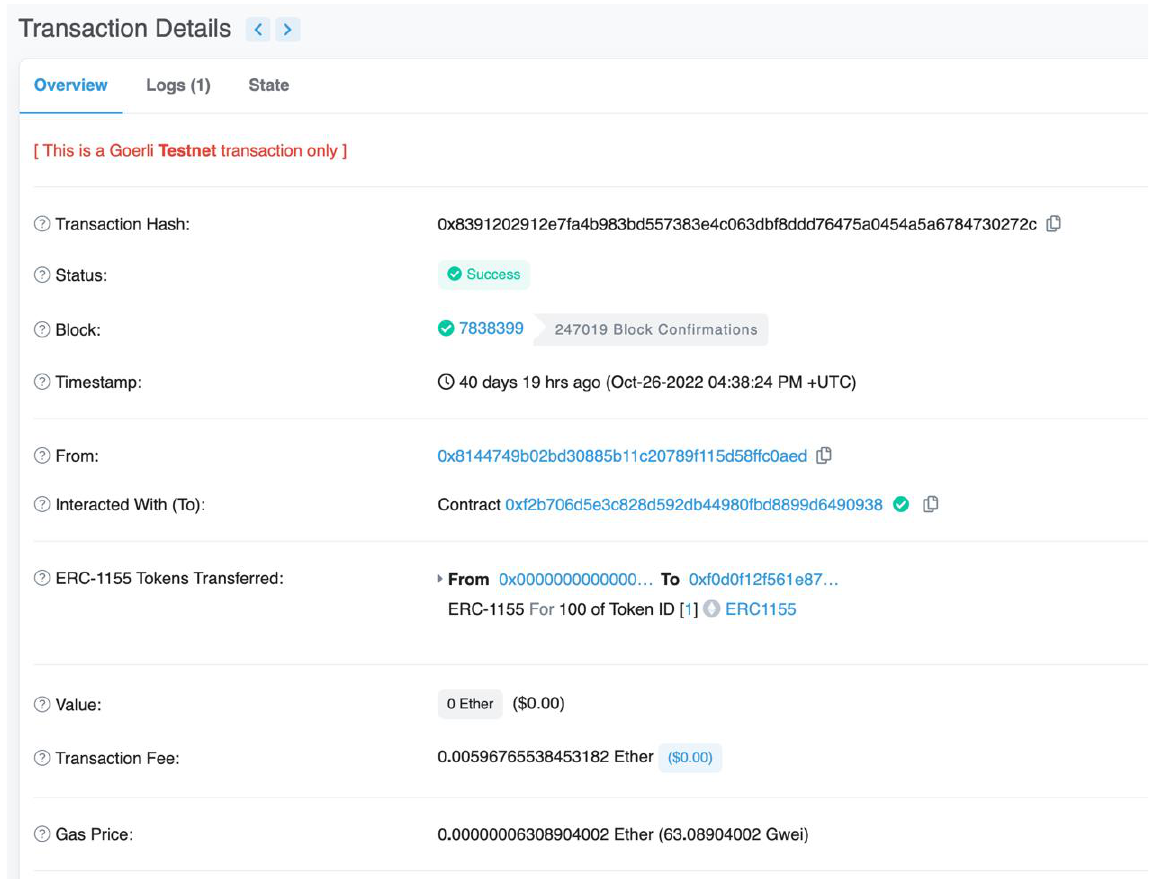
Figure A16. Proof of locking in collateral on Etherscan.